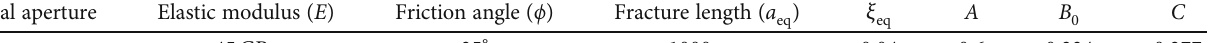
Table 3: Parameter values used for matching the data in the crack extension phase. Initial aperture